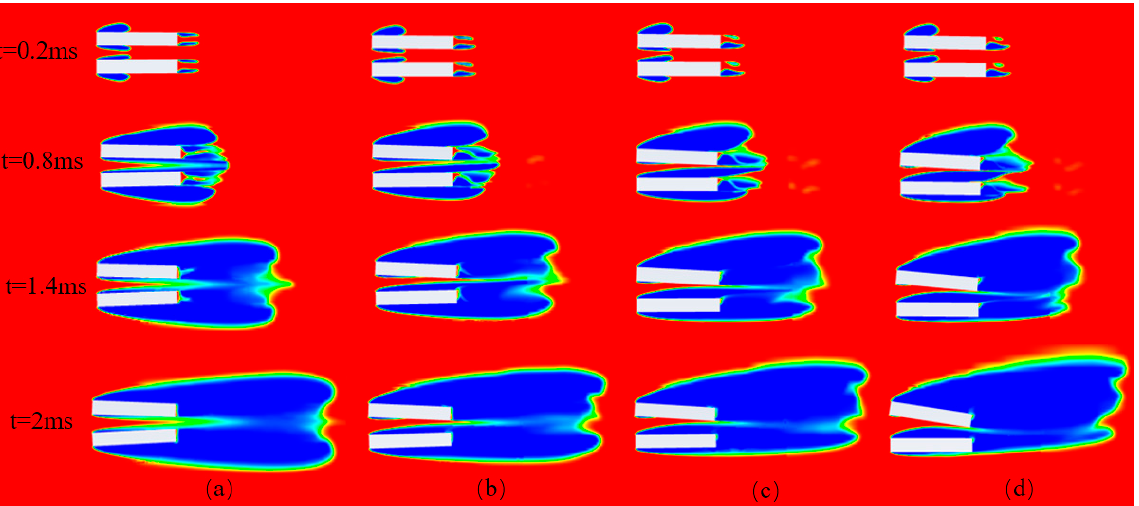
Figure 9. Evolution of the cavitation of parallel projectiles at different conditions: ( a ) no lateral flow; ( b ) the lateral flow velocity V c = 3.75% V p ; ( c ) V c = 7.5% V p ; ( d ) V c = 11.25% V p.